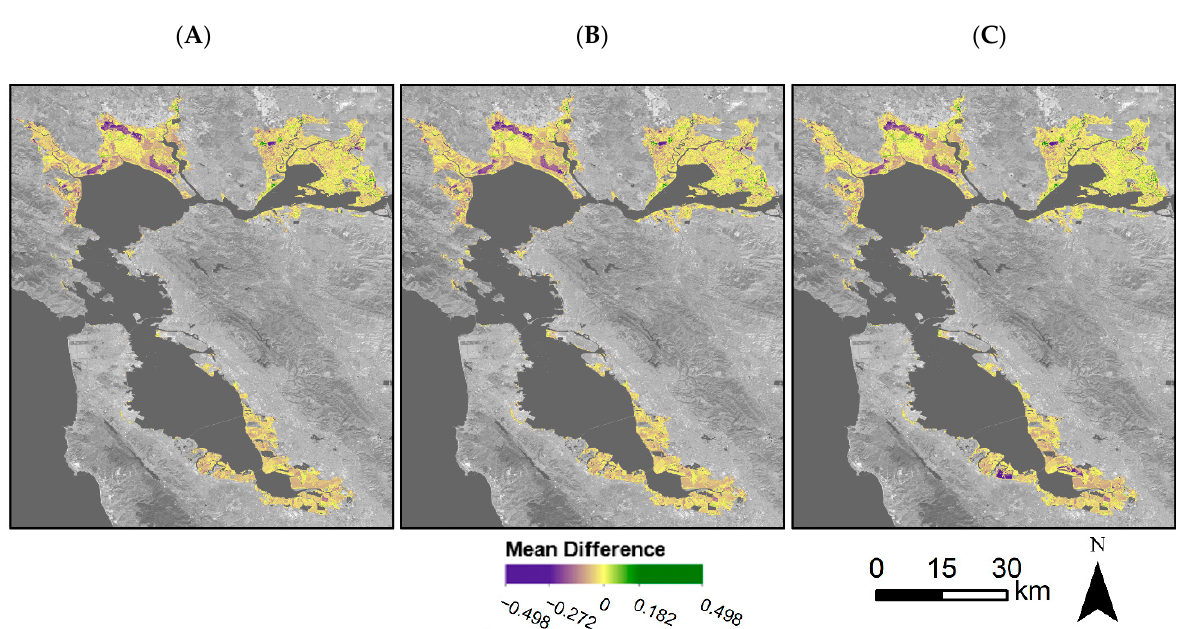
Figure 8. Mean difference between predicted EVI and Landsat observed EVI for 2019 for ( A ) Landsat 8-derived EVI history, ( B ) Landsat 8- and Sentinel-derived EVI history, and ( C ) Landsat 7-, Landsat 8-, and Sentinel-derived EVI history. Mean difference refers to the Landsat observed minus predicted EVI values. Mean difference was set to zero if the observed values fell within the predicted 95% confidence interval, or the phenological envelope. The areas in purple indicate an overprediction in the model while areas in green indicate an underprediction in the model. Basemap: Landsat 8 band 7 (SWIR 2) U.S. Geological Survey.